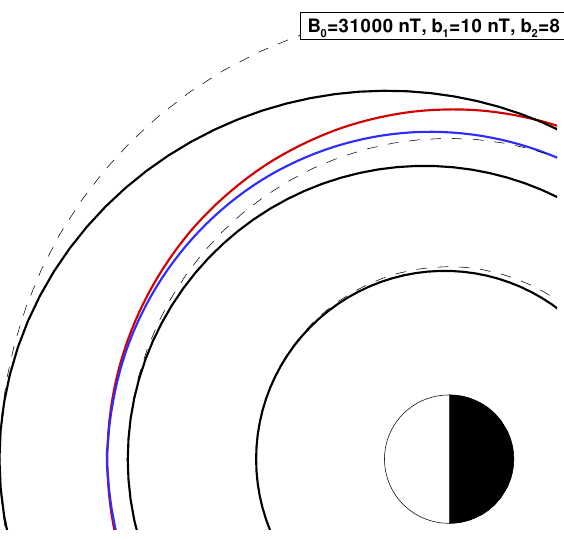
Fig. 5. Two contours of constant period (red – mode with azimuthal equatorial electric field at midnight, blue – mode with radial electric field at midnight) which intersect at a point on the noon meridian.